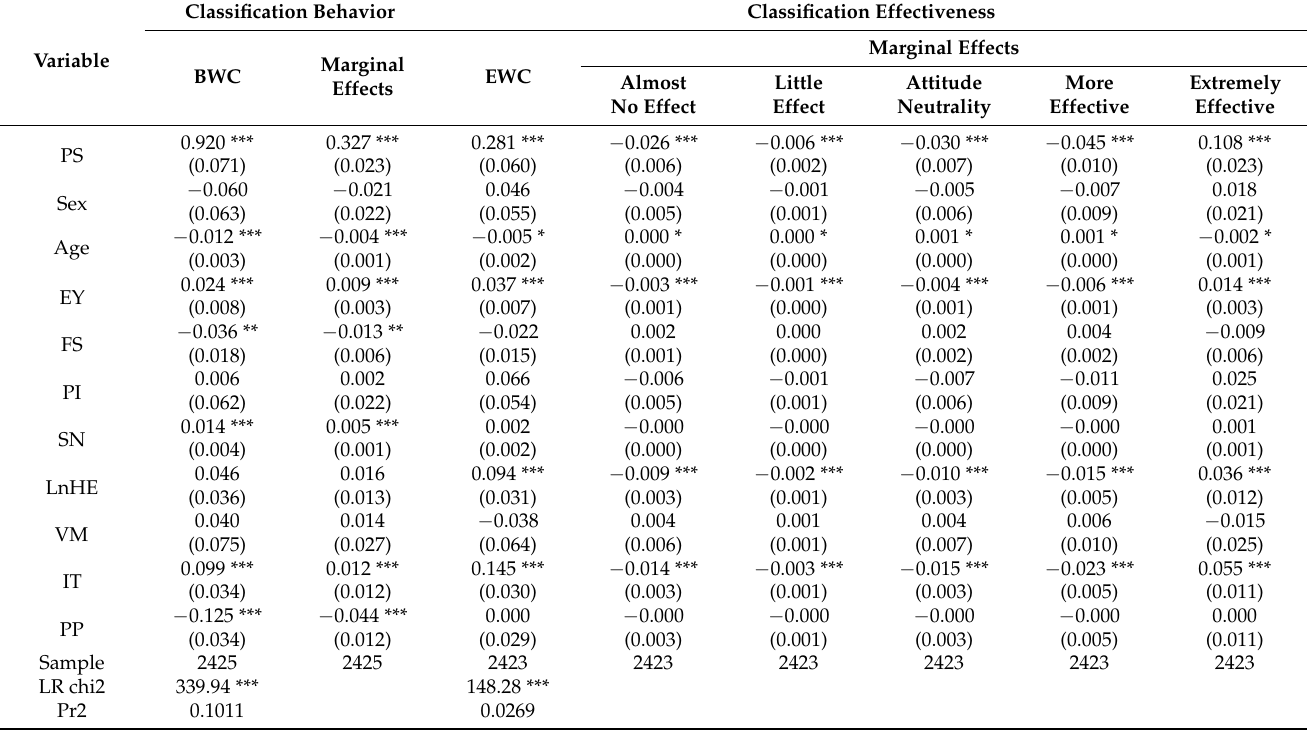
Table 6. Impact of PS on the BWC and